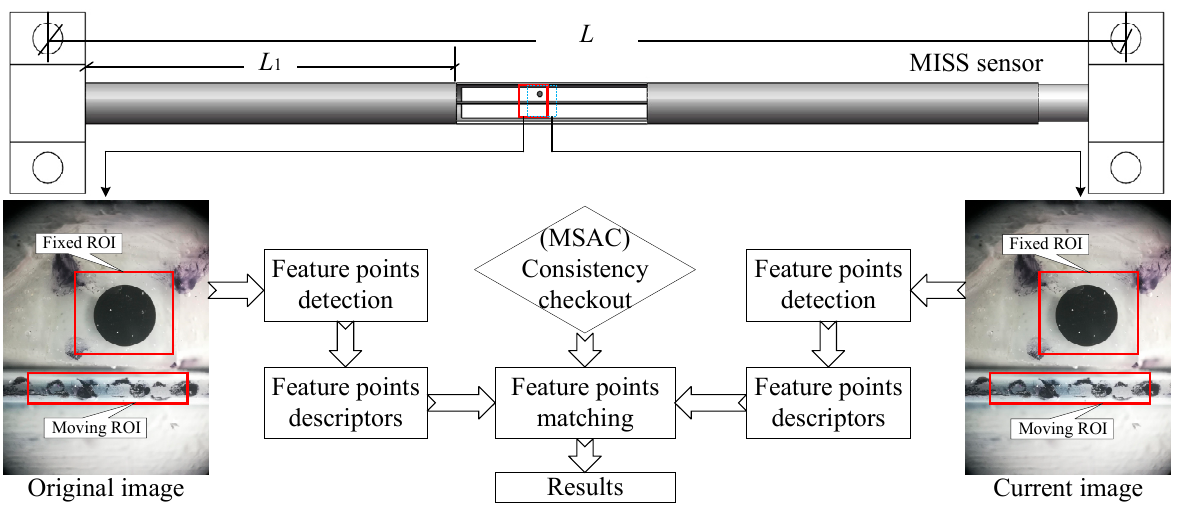
Figure 1. The process diagram of the MISS method based on the SURF and MSAC algorithms. The fixed region of interest (ROI) represents a fixed area is fixed, and the moving ROI can move horizontally. L represents the length of the MISS sensor, and L 1 is the length of the left tube.